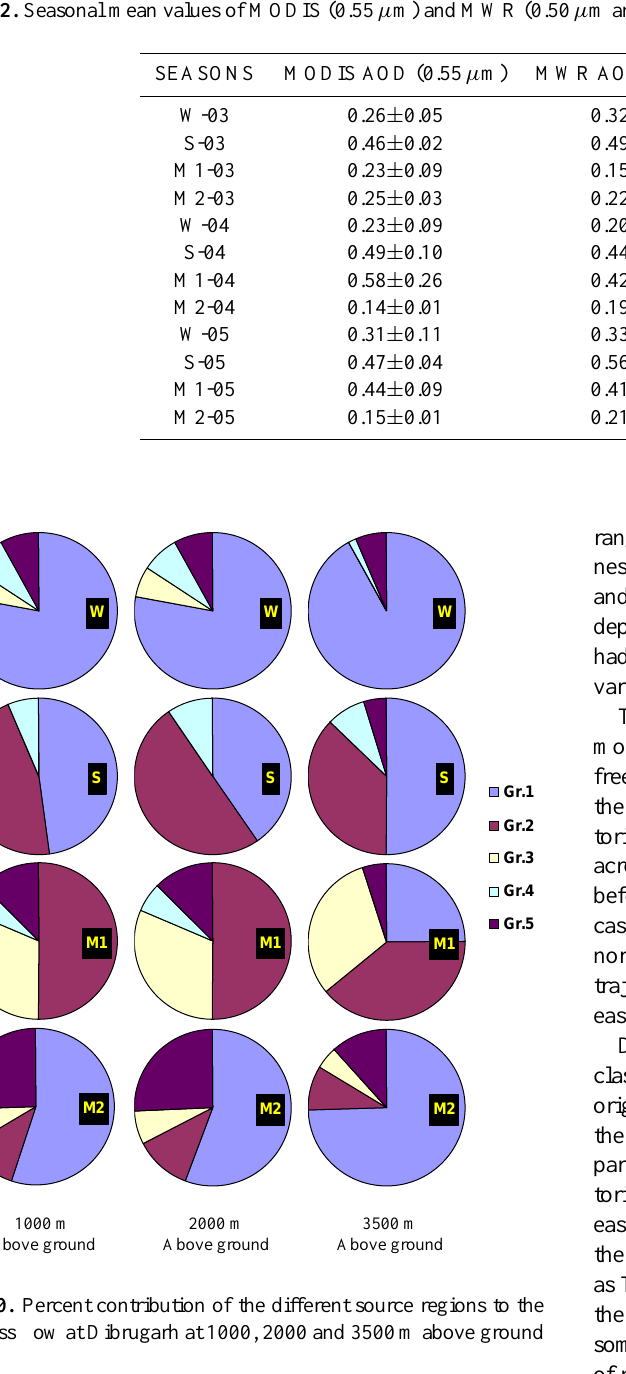
Table 2. Seasonal mean values of MODIS (0.55 µ m) and MWR (0.50 µ m and 0.60 µ m) derived AOD.